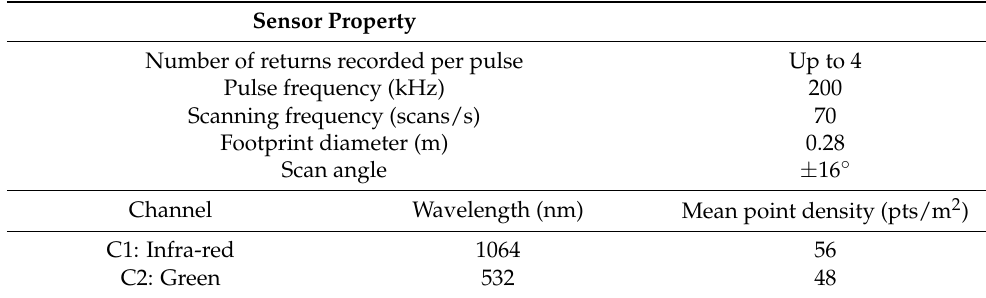
Table 3. ALS sensor